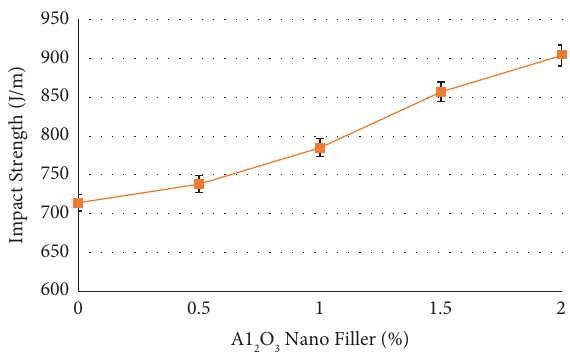
Figure 7: Impact strength of epoxy hybrid composites.